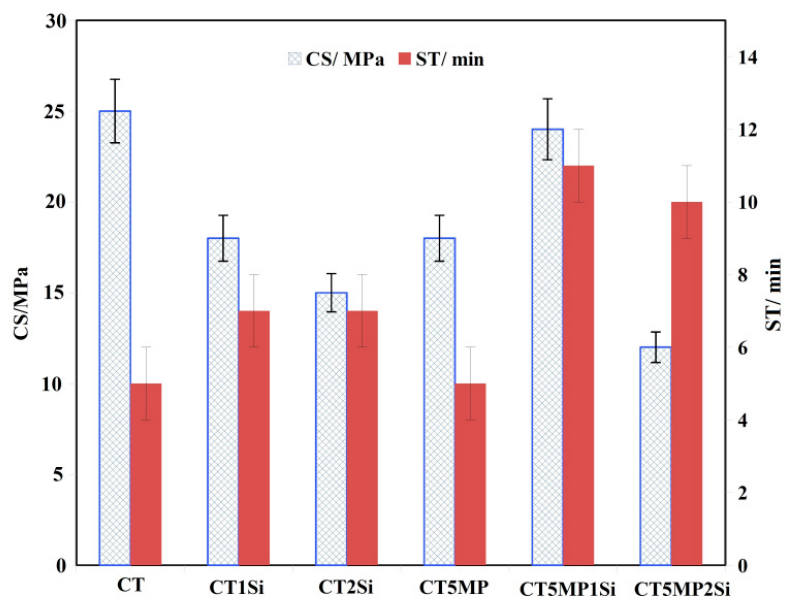
Figure 5. Setting time and compressive strength of cements after 7 days hardening in SBF at 37 °C.